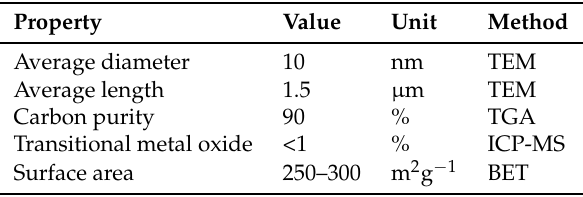
Table 2. Physical properties of NC7000 TM carbon